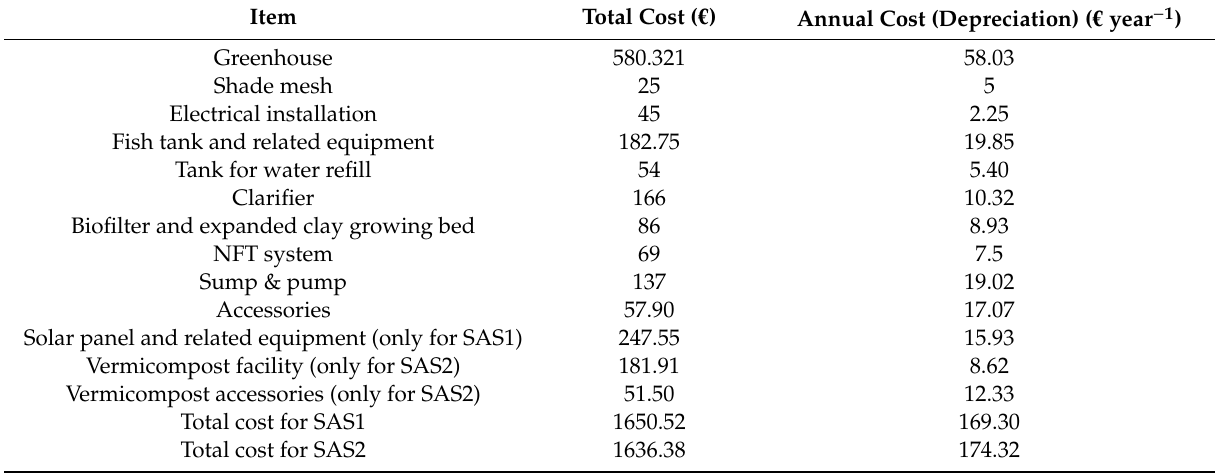
Table A2. Construction and equipment costs for the SAS (VAT included).